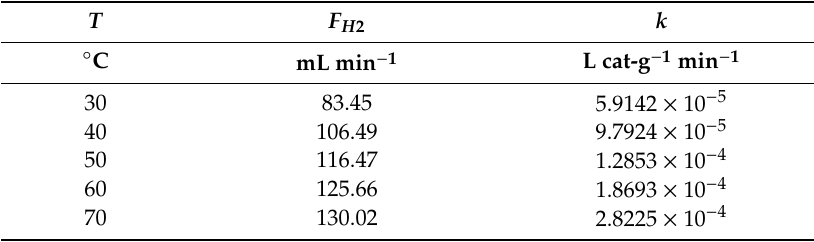
Table 1. The experimental hydrogen generation rates vs. reactor operating